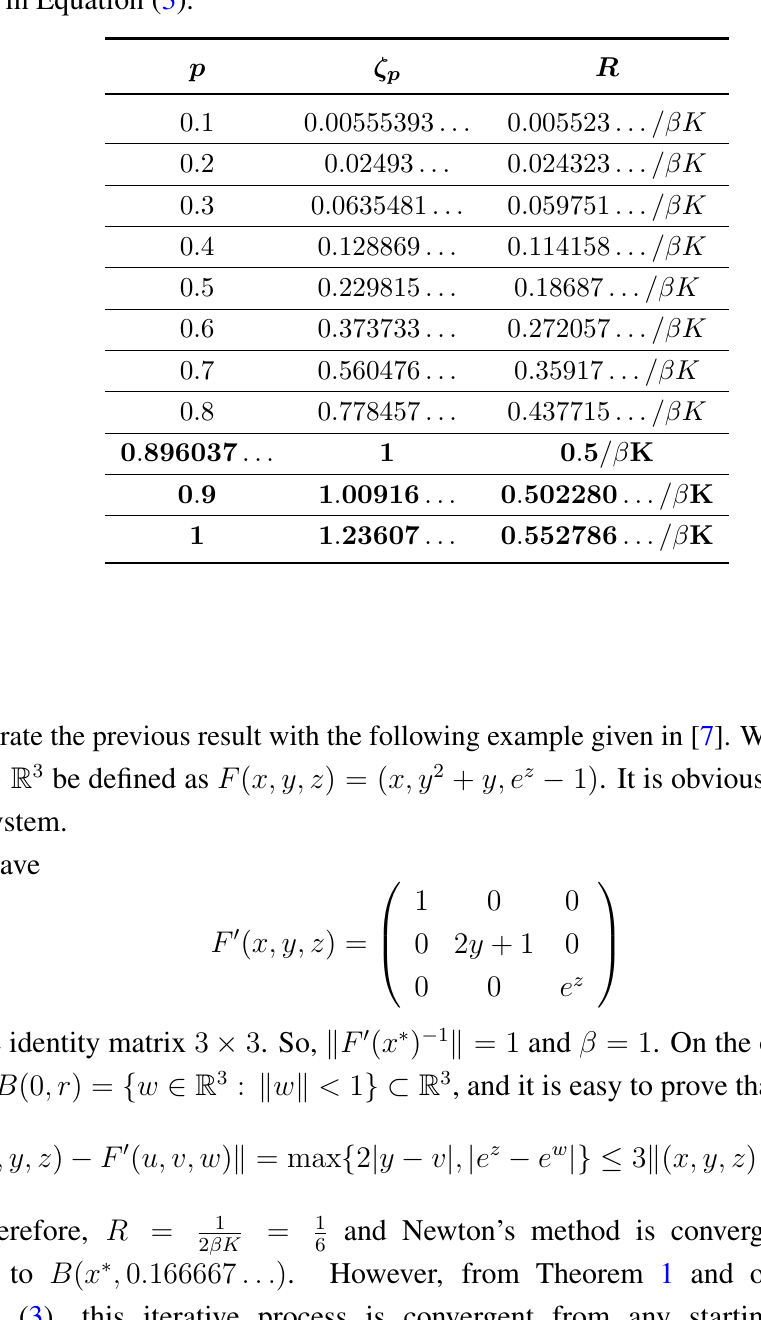
Table 1. Positive real roots of the equation g ( t ) − 1 = 0 and the values of R for different values of p in Equation